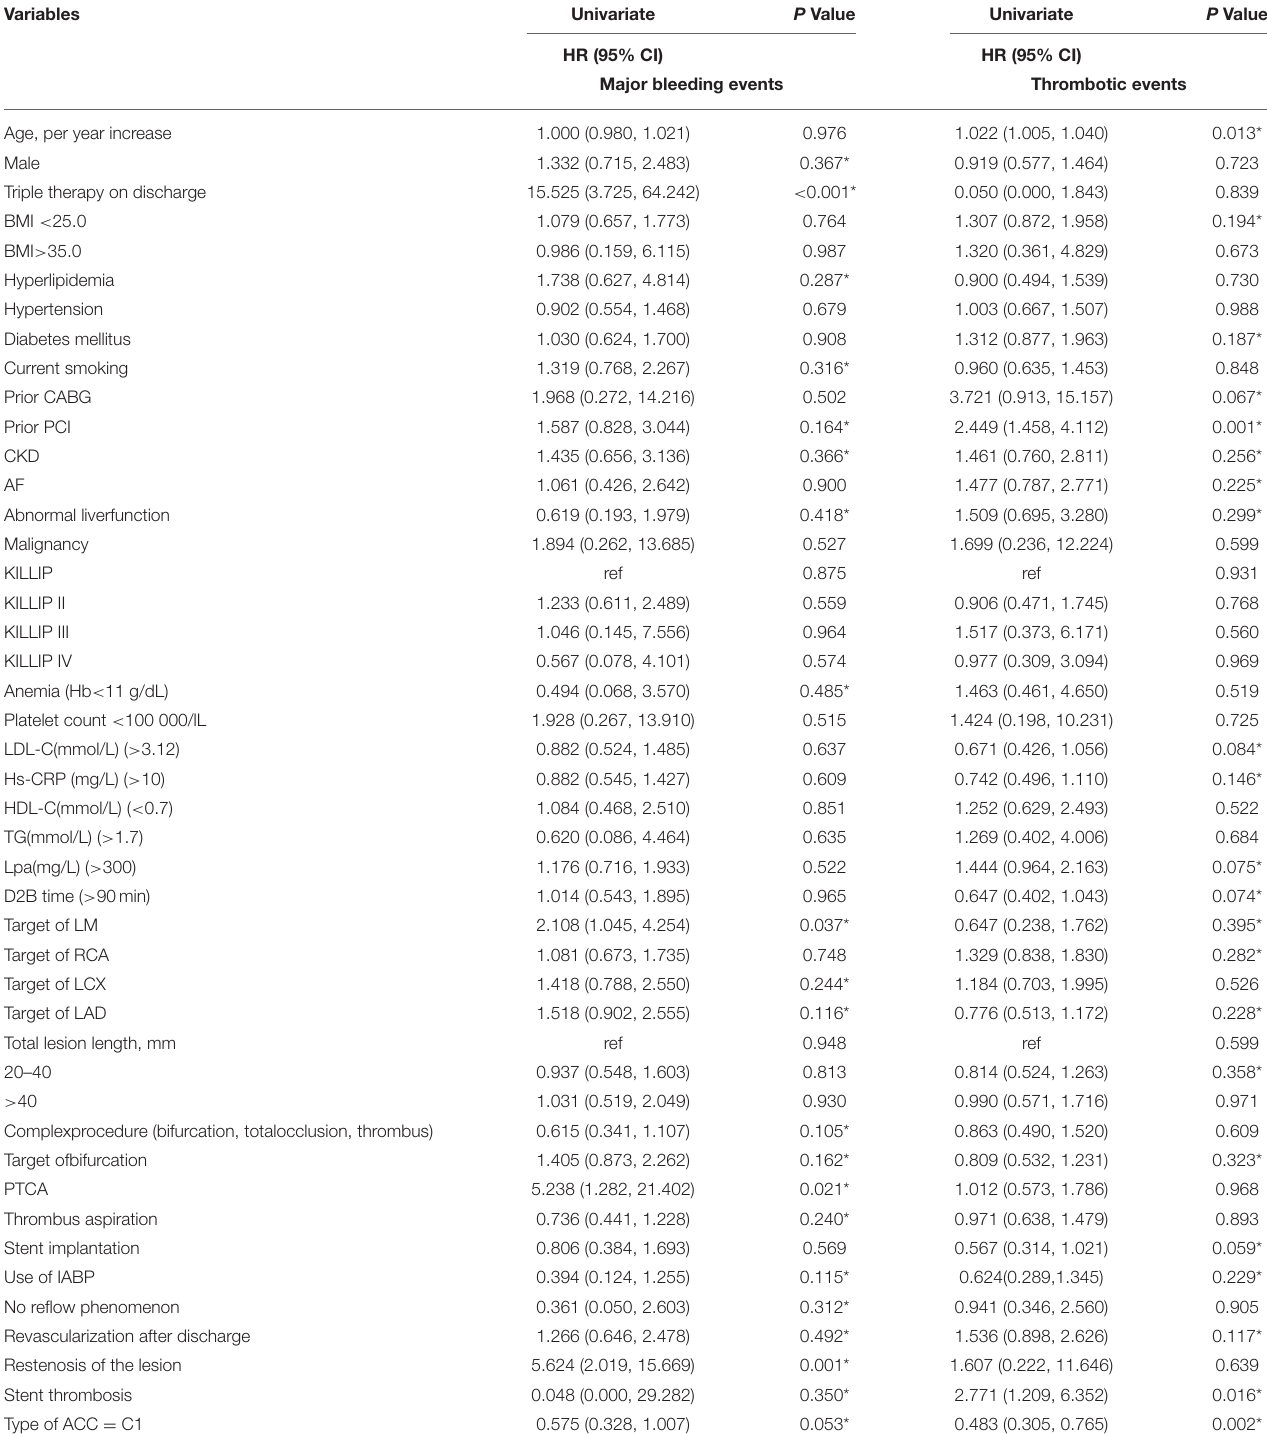
TABLE 2 | Univariate Cox analysis for major bleeding events and thrombotic events in the derivation cohort.